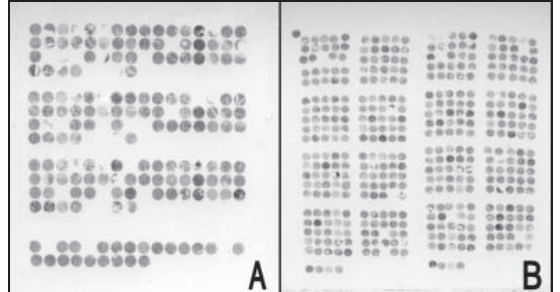
Figura 1 – Detalhe da lâmina corada por hematoxilina e eosina (HE) obtido a partir dos blocos receptores. A: construído com amostras de 1 mm e espaçamento de 0,2 mm. Os casos foram divididos em minimatrizes que separam os componentes histológicos do tumor de Wilms, restos nefrogênicos e parênquima renal normal. B: construído